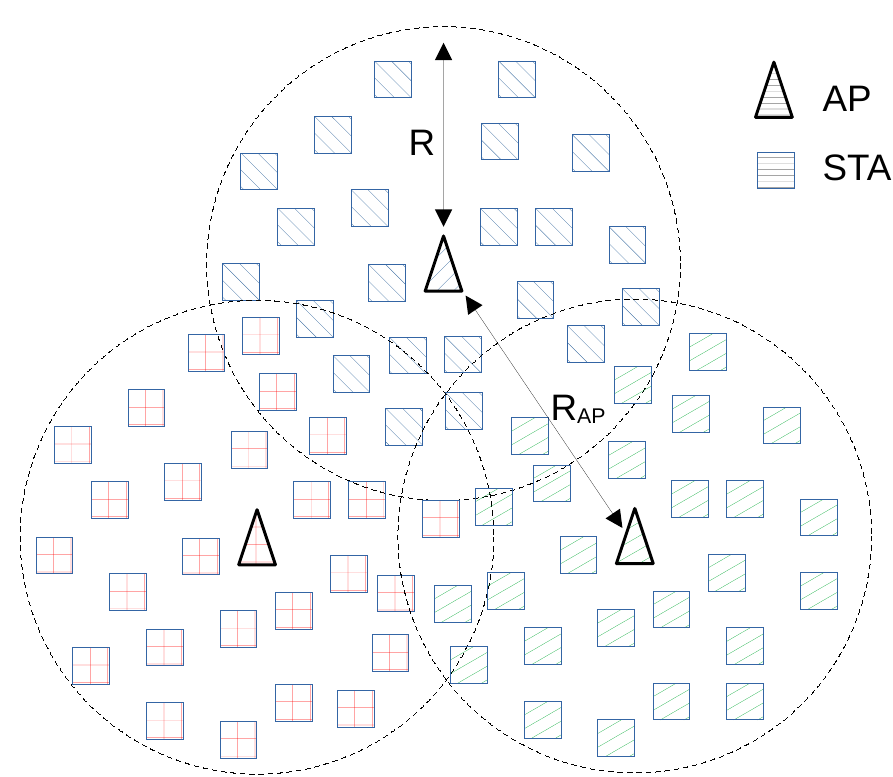
Figure 3. Studied network scheme: different kinds of hatching show different basic service